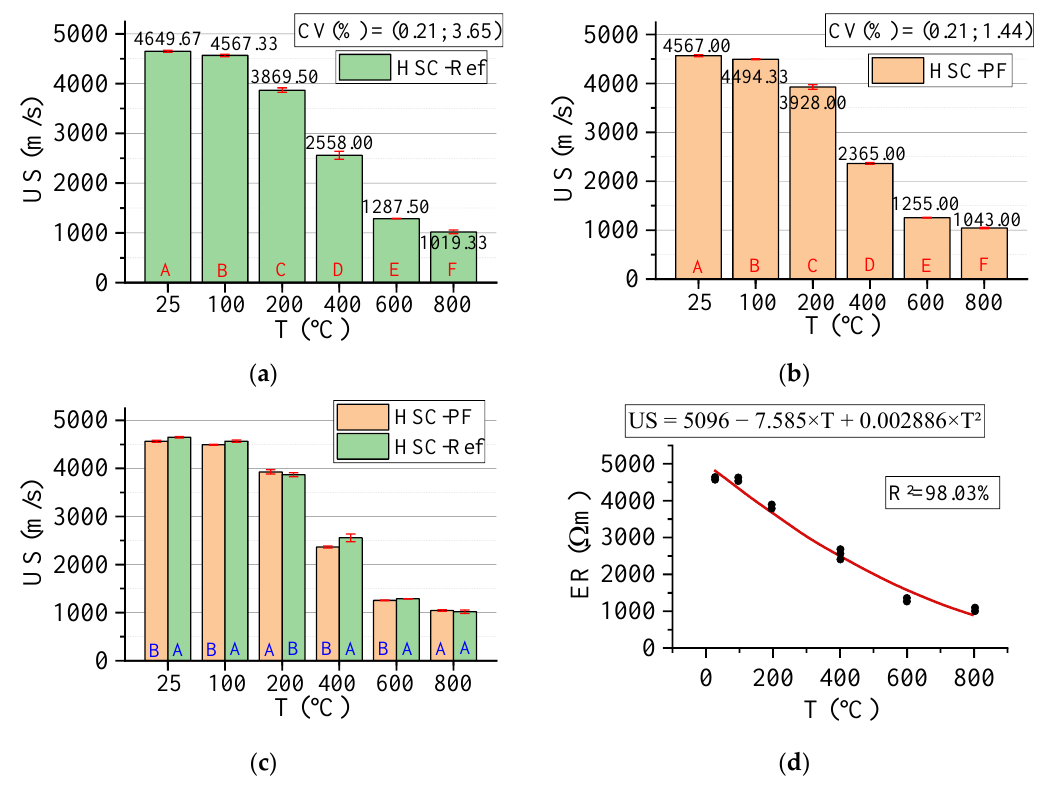
Figure 18. Summary of ultrasonic speed (US) results: ( a ) Tukey’s test for the samples without polypropylene fibers, ( b ) Tukey’s test for the samples with polypropylene fibers, ( c ) Tukey’s test for the samples without and with polypropylene fibers and ( d ) Quadratic regression model fit to the experimental data set considering only the effect of temperature as an independent factor. The uppercase letters A – F in figure mean equivalence between the sample results.